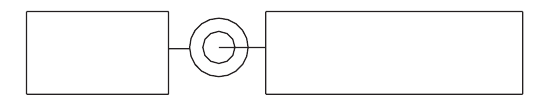
Figure 3: Model for the cracked beam with sectional